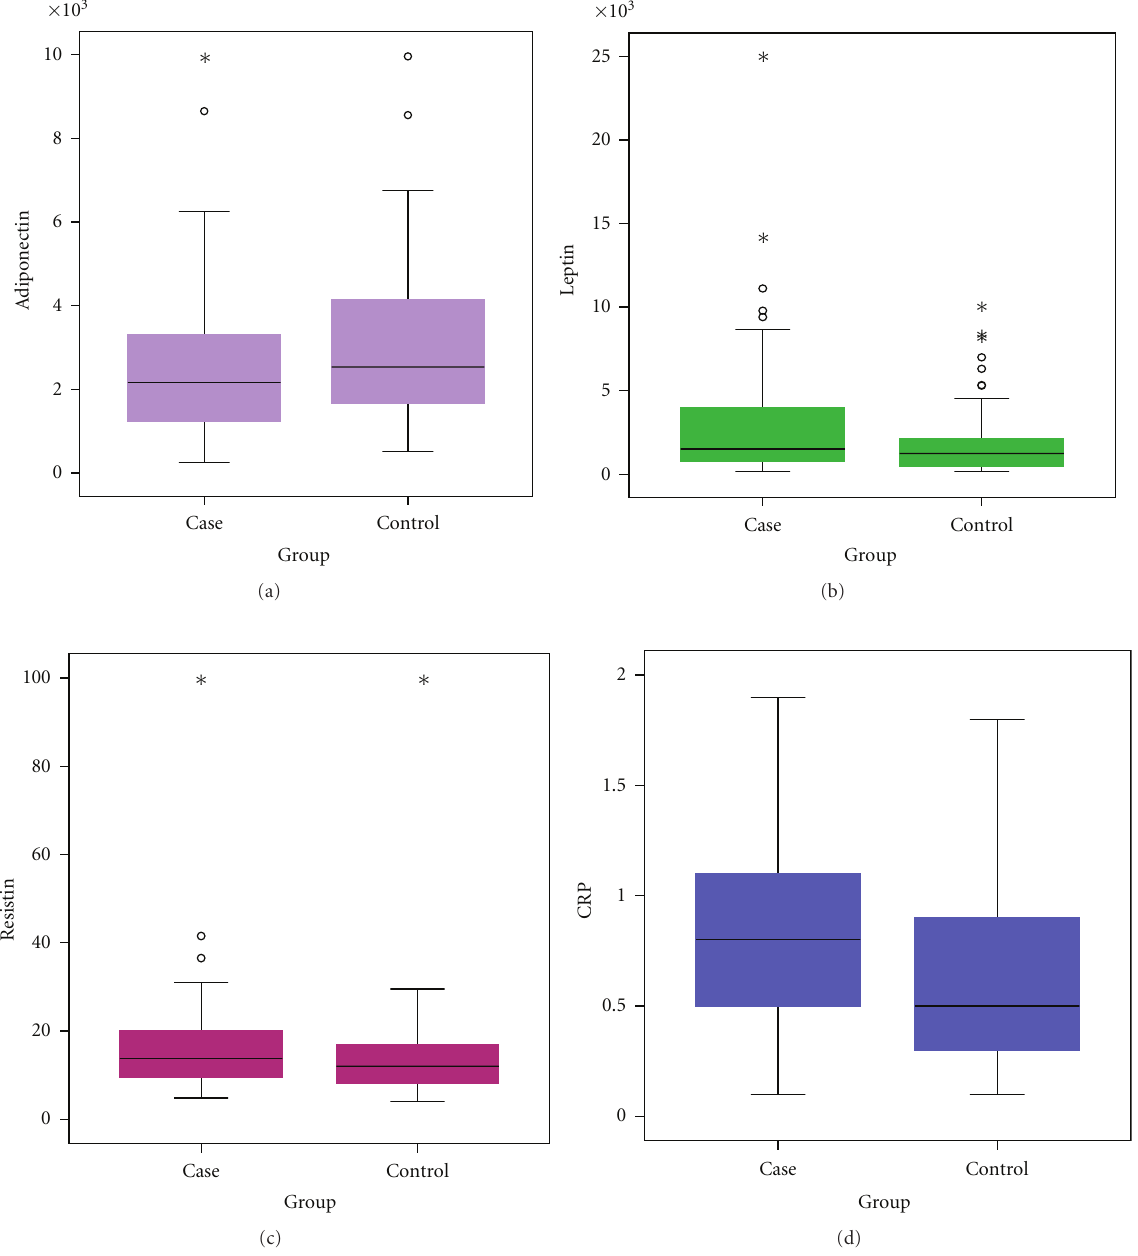
Figure 1: The graphic representation of the serum levels ranges of the inflammation markers (adipokines, CRP) in the PAOD patients and the control